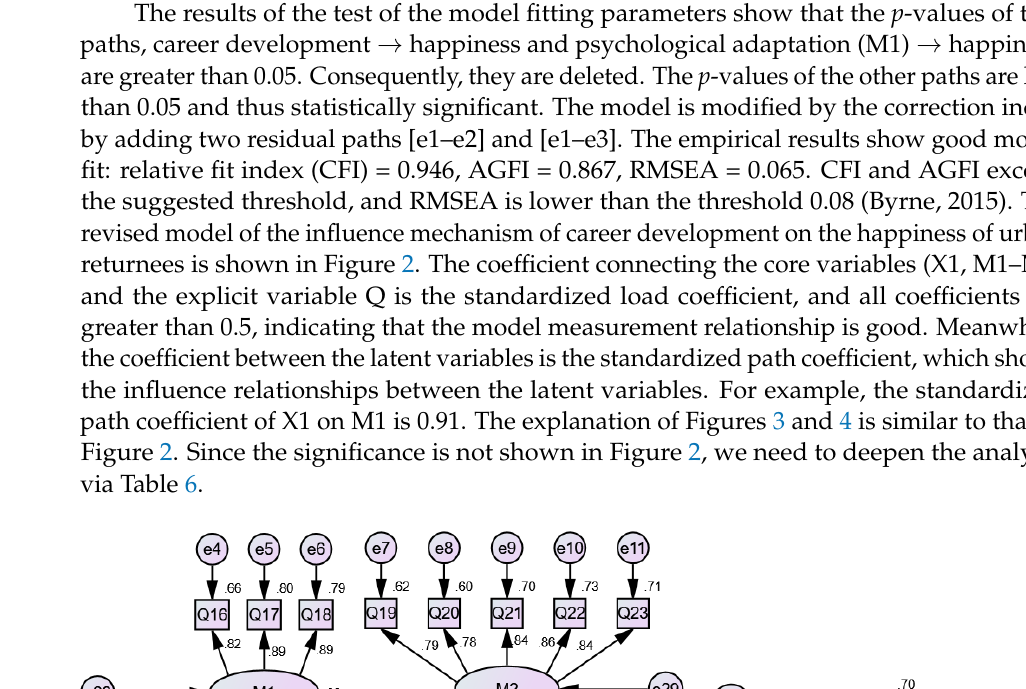
Figure 3. A revised model of the influence mechanism of institutional factors on the happiness of urban returnees.